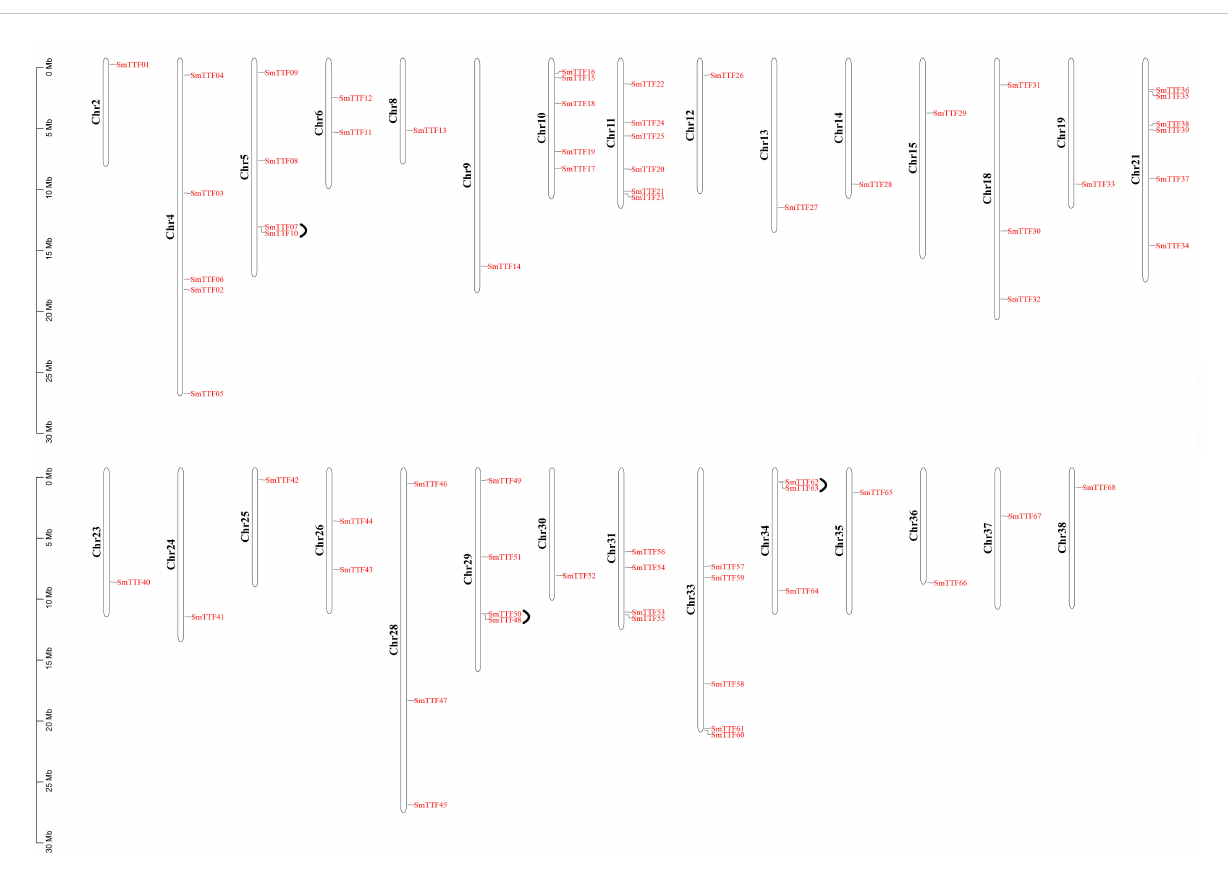
FIGURE 3 Chromosomal locations and tandem duplication of S. matsudana trihelix genes. The black lines indicate tandem duplicated trihelix gene pairs. The chromosome number is indicated to the left of each